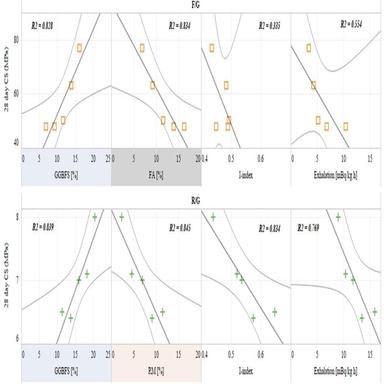
Comparison of the fly ash (FA), red mud (RM) and ground granulated blast furnace slag (GGBFS) content, I-index and exhalation with 28-day compressive strength (CS) properties in the fly ash and ground granulated blast furnace slag (F/G) and red mud and ground granulated blast furnace slag (R/G) series where the trendlines were placed with 95% confidence bands.